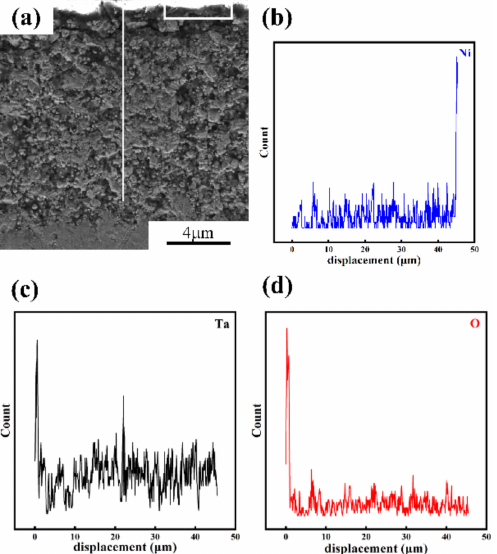
Figure 14. Corrosion fracture image of the cermet C : ( a ) SEM image; ( b – d ) corresponding EDS